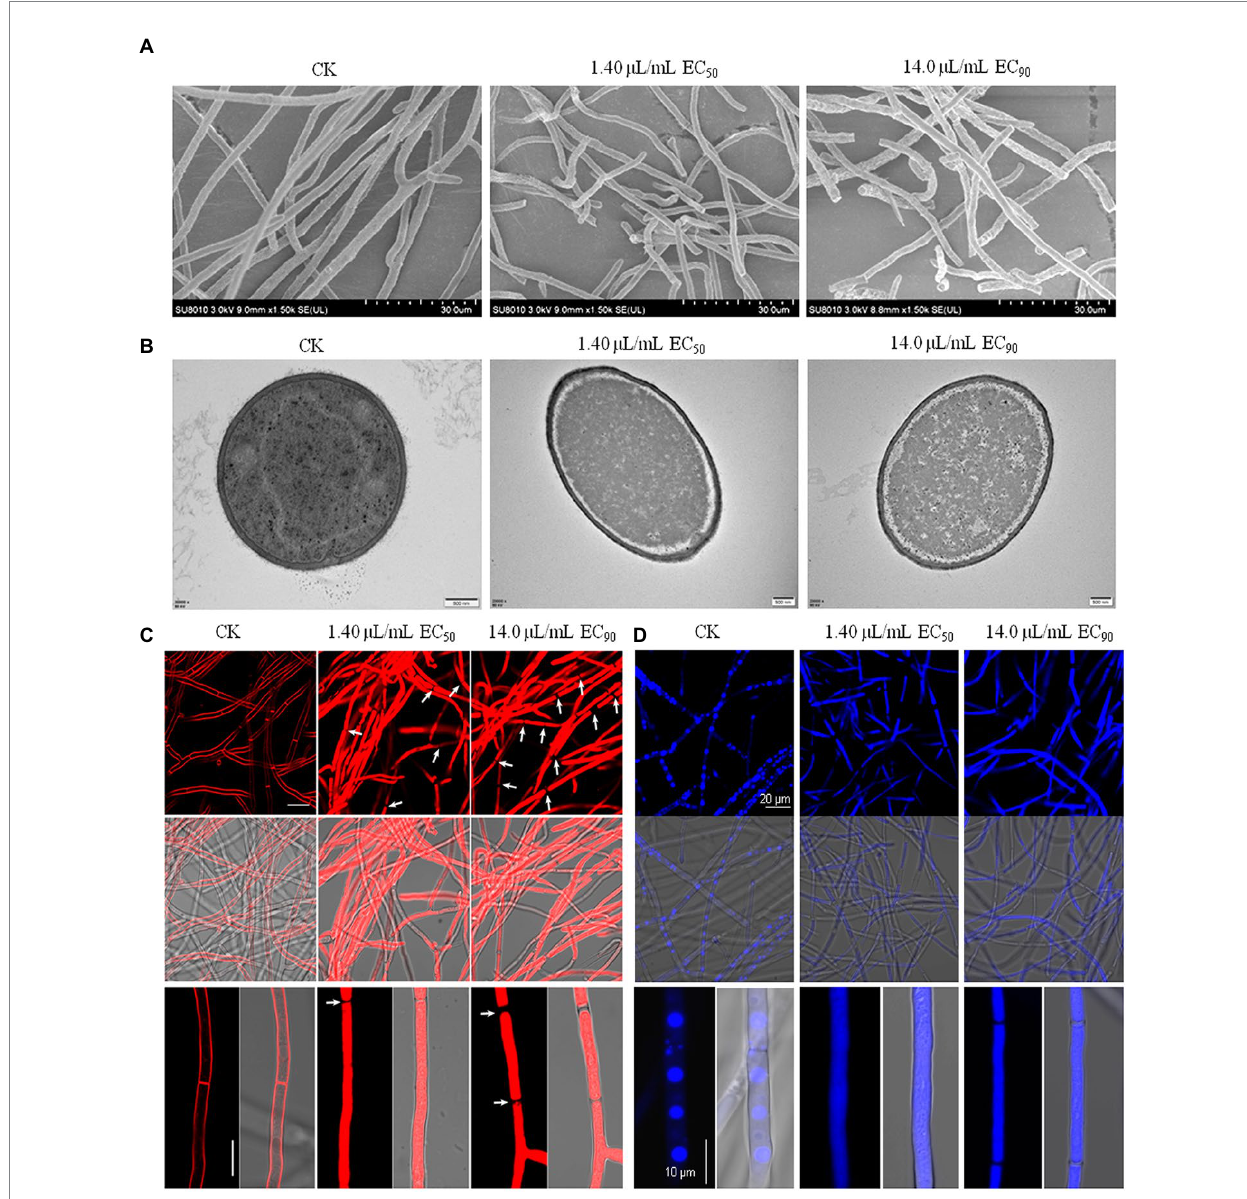
FIGURE 2 Limonene formulation disrupted hyphal morphology and structures of Fusarium graminearum . (A) SEM images of PH-1 mycelia treated with or without limonene formulation treatments. Bars, panel = 30 μ m. (B) TEM images of PH-1 mycelia after treated with limonene formulation. Bars, panel = 500 nm. (C) FM4-64 staining analyze the influence of limonene formulation on cell membrane. (D) Fluorescence images of the vacuoles in hyphae after staining with